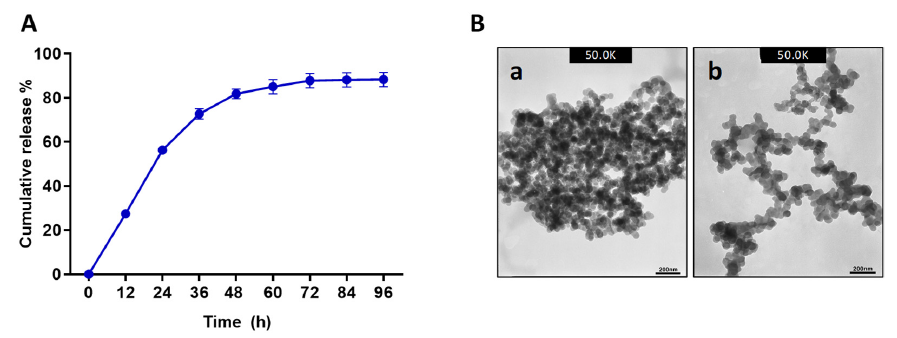
Figure 1. The cumulative release profile of Octominin-CNPs and morphology of Octominin-CNPs and CNPs ( A ) The cumulative release profile of Octominin from Octominin-CNPs in PBS (pH 7.4) at 37 ◦ C and